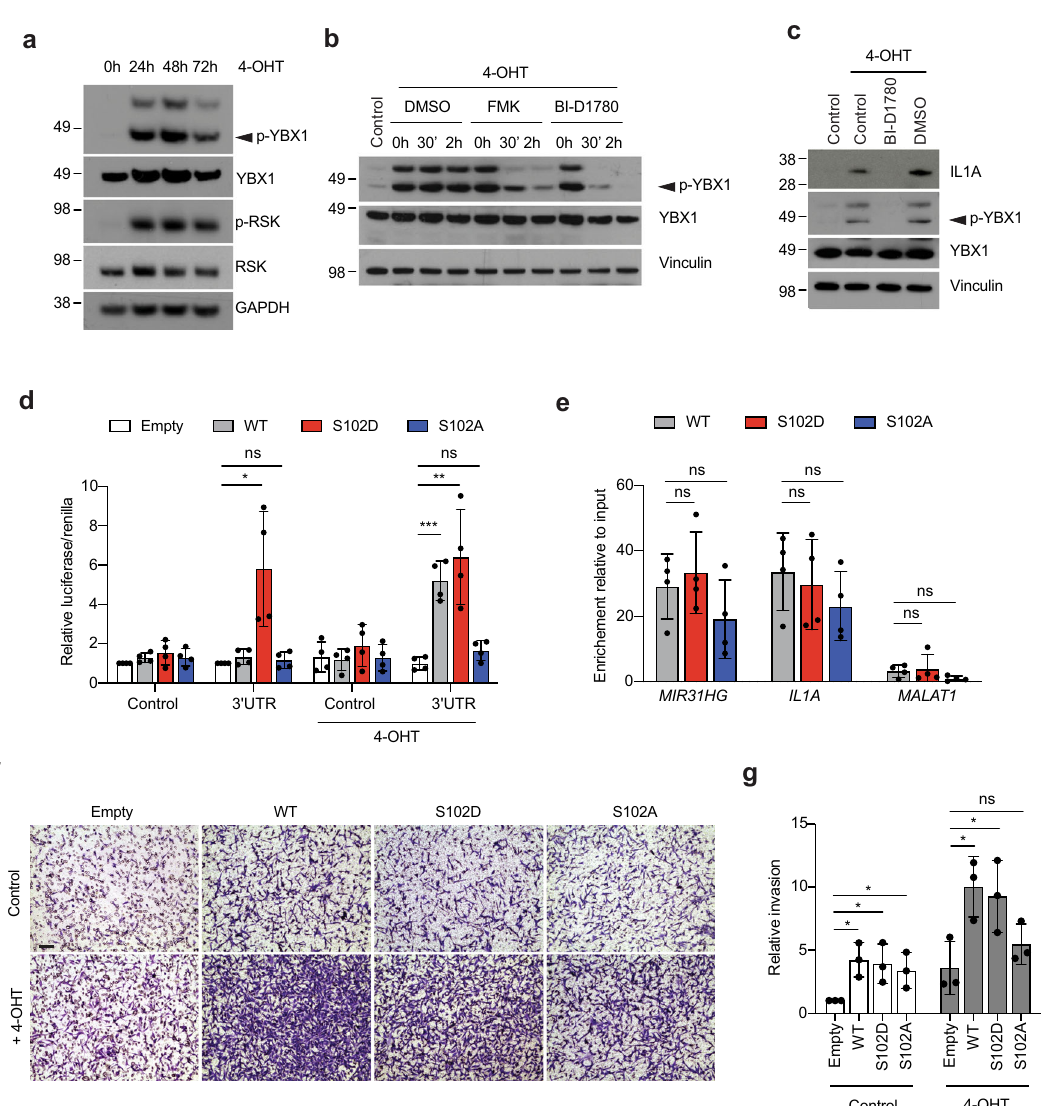
Fig. 5 Phosphorylated YBX1 induces IL1A translation. a Western blot for p-RSK1, RSK1, p-YBX1, total YBX1 and Vinculin in BJ ER:BRAF cells treated with 1